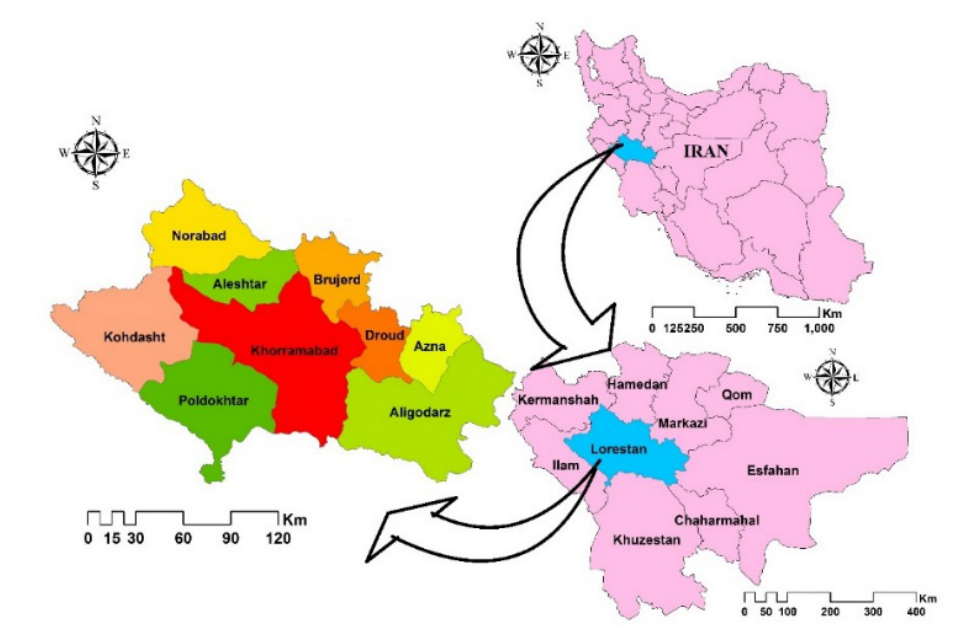
Figure 1. The study